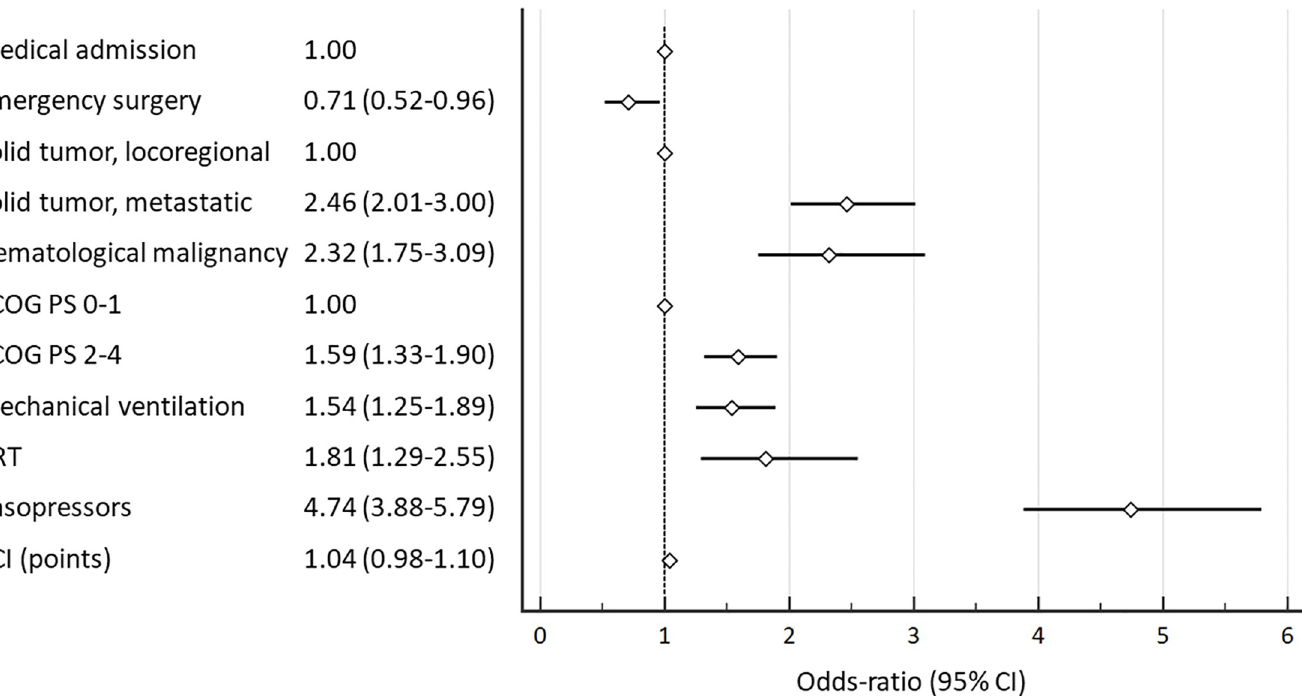
Fig 2. Mixed effect logistic regression analysis for risk factors associated with hospital mortality.